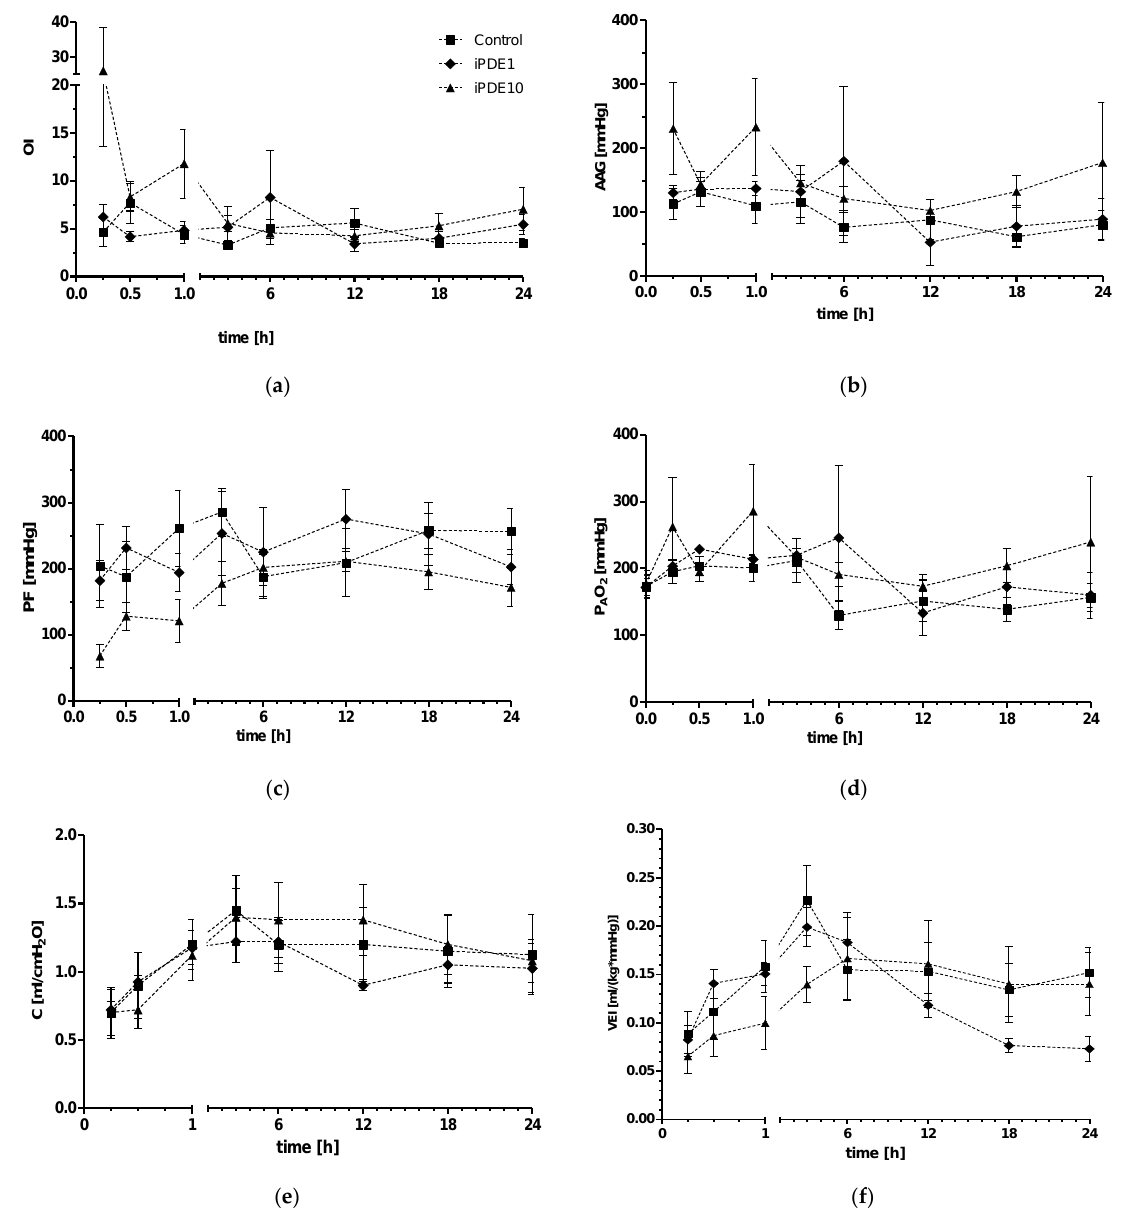
Figure 1. Parameters of oxygenation, including ( a ) Oxygenation index (OI), ( b ) alveolar-arterial gra- dient (AAG), ( c ) Horowitz score (PF), ( d ) alveolar partial pressure of oxygen (P A O 2 ), and parameters of ventilation including ( e ) compliance, ( f ) ventilator efficiency index (VEI), during the course of the experiment in animals in control group ( ■ ), iPDE1 group ( ♦ ) and iPDE10 group ( ▲ ), given as mean ± SEM.